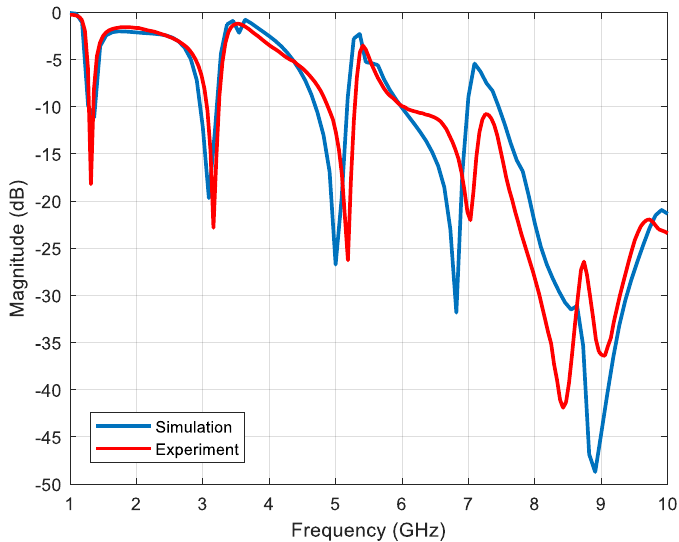
Figure 11. Simulated and measured |S 21 | data without the presence of object.